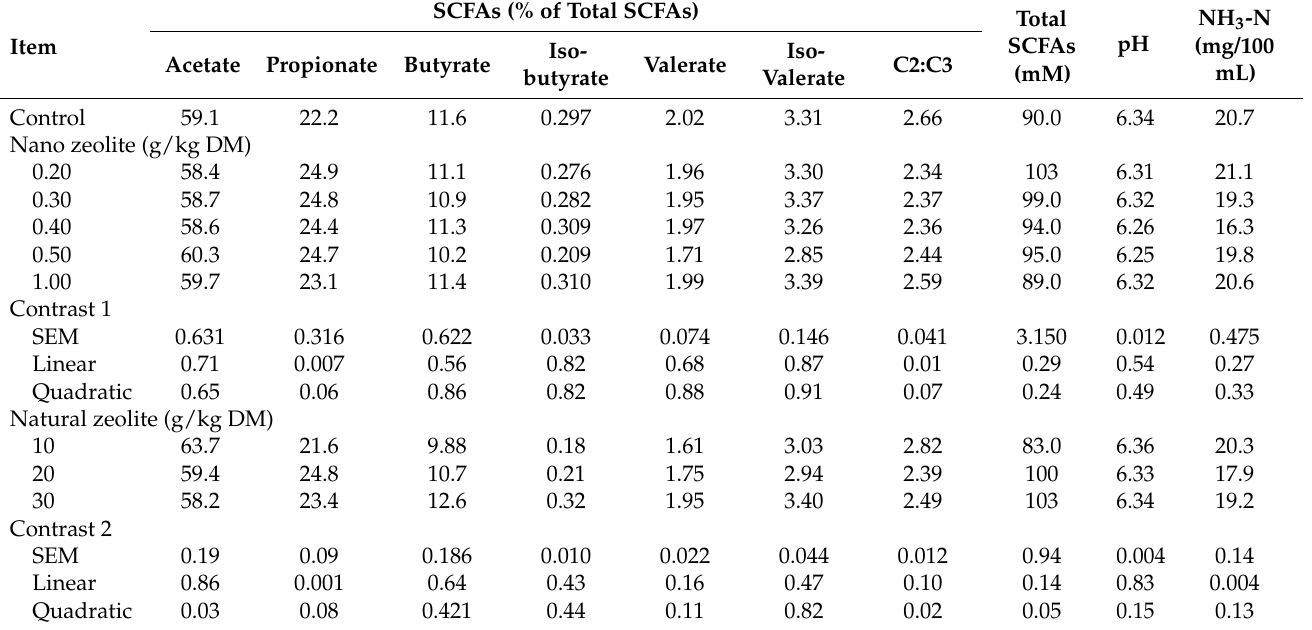
Table 5. Supplementation effects of natural or nano-zeolite on ruminal total short-chain fatty acids (SCFAs) concentration, molar proportions of individual SCFAs, pH, and ammonia nitrogen (NH 3 -N) concentrations through 24 h incubation period ( in vitro experiment).